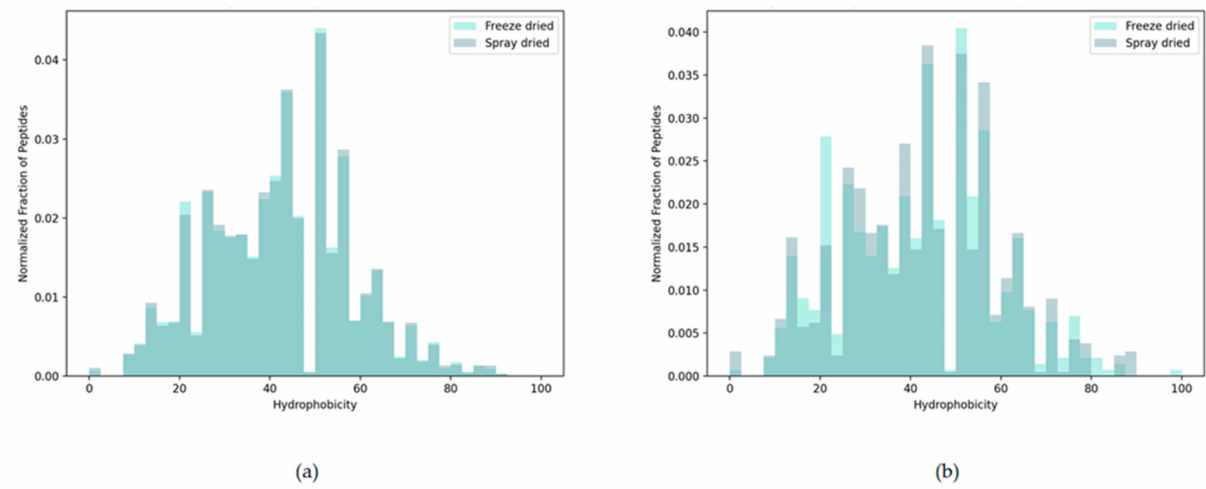
Figure 5. Peptide distribution according to hydrophobicity in FD and SD samples of rice NPN. The peptide profile as determined by LC-MS/MS in a histogram representation of rice NPN samples, peptide distribution is according to hydrophobicity, calculated from % of hydrophobic residues, in ( a ) peptides present in full samples or ( b ) peptides exclusive in either FD (teal bar) or SD (blue bar) samples. All data is normalised for